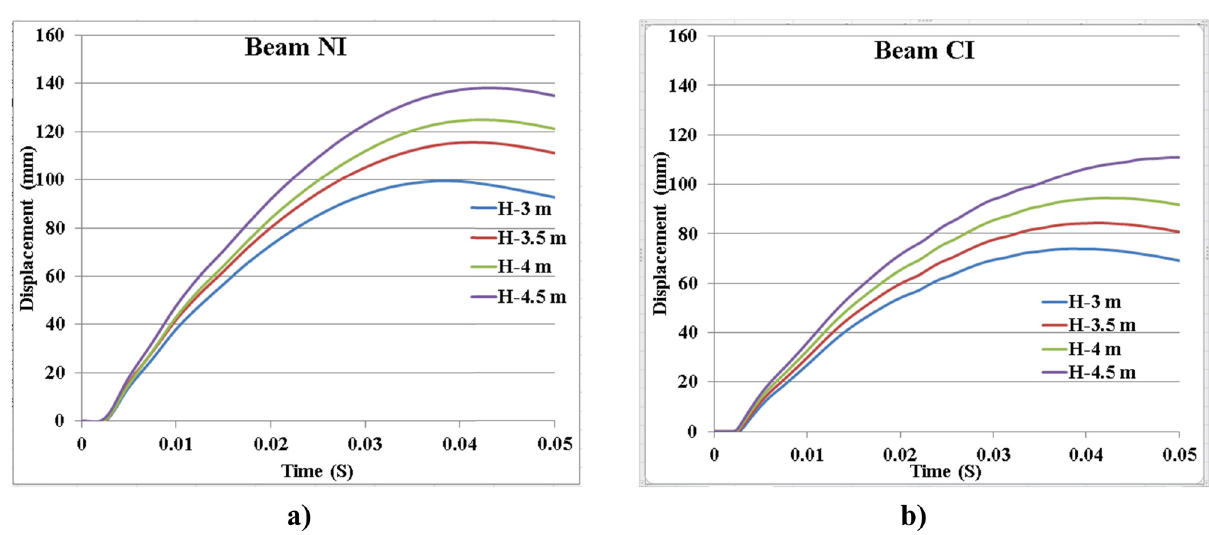
Figure 5: Displacement – time history of the beams NI and CI for di ff erent impact velocities. ( a ) For the NI beam and ( b ) for the CI